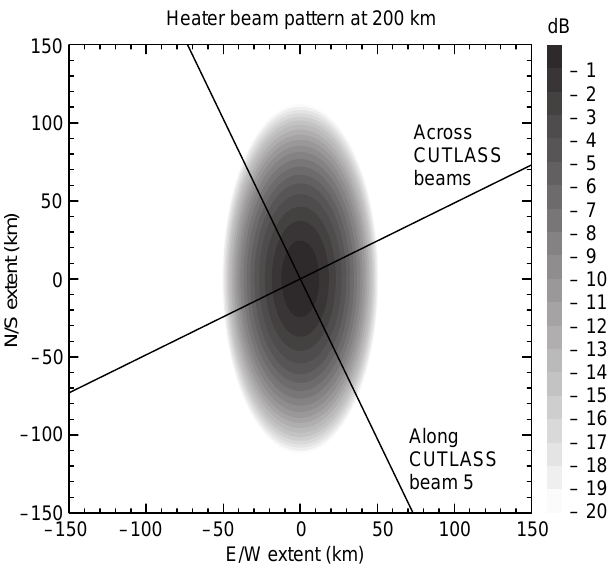
Fig. 5. A contour plot illustrating the power distribution of the heater beam at an altitude of 200km. The shading presents the power in dB below the power at the centre of the beam. The straight lines indicate the directions along and normal to CUTLASS Finland beam 5